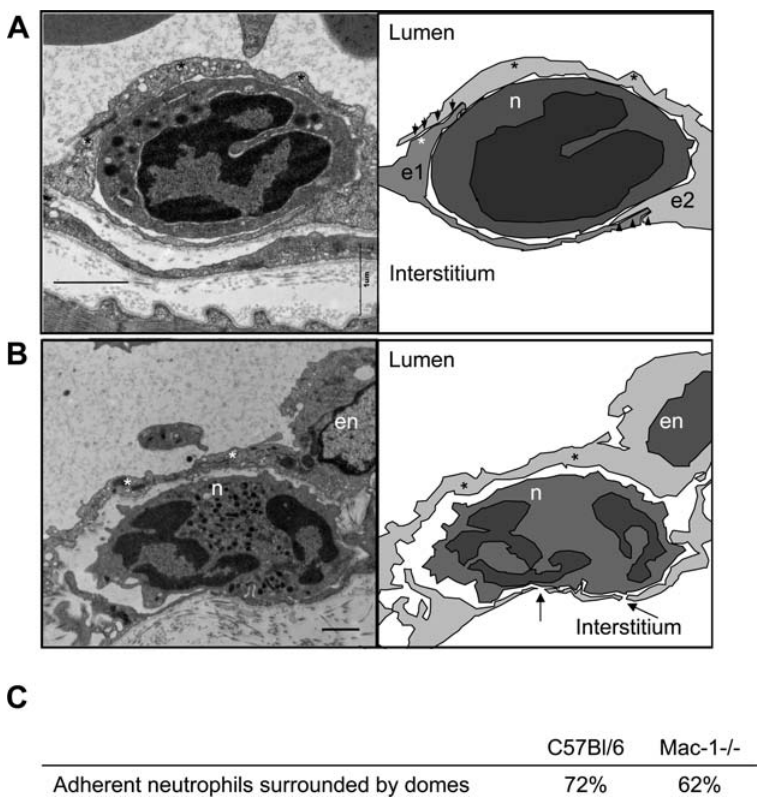
Figure 3. Endothelial enscapsulation of transmigrating neutrophils. Electron micrographs and cartoons of transmigrating wild-type (A) and Mac-1 deficient neutrophils (B). The arrowheads mark the junctions seen in A, the thin endothelial sheet that covers the transmigrating cells is marked with *, e1, e2 and n represent individual endothelial cells and neutrophils respectively. The arrows in B mark gaps in the endothelium, and en marks the endothelial nucleus. Scale bars correspond to 1 m m. The images represent 1 out of 40 analyzed wild-type and 1 out of 24 Mac-1-/- neutrophils. In panel C are presented the percentages of the adherent neutrophils that were covered by endothelial dome-structures.